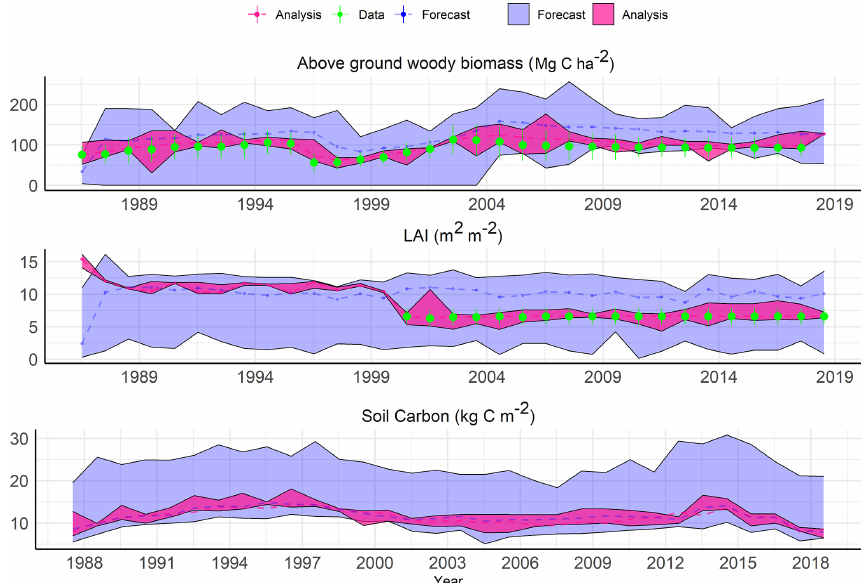
Figure 7. Site-level example of sequential data assimilation in an eastern temperate forest ecoregion for a coniferous site (longitude = − 89 . 226, latitude = 33 . 21).